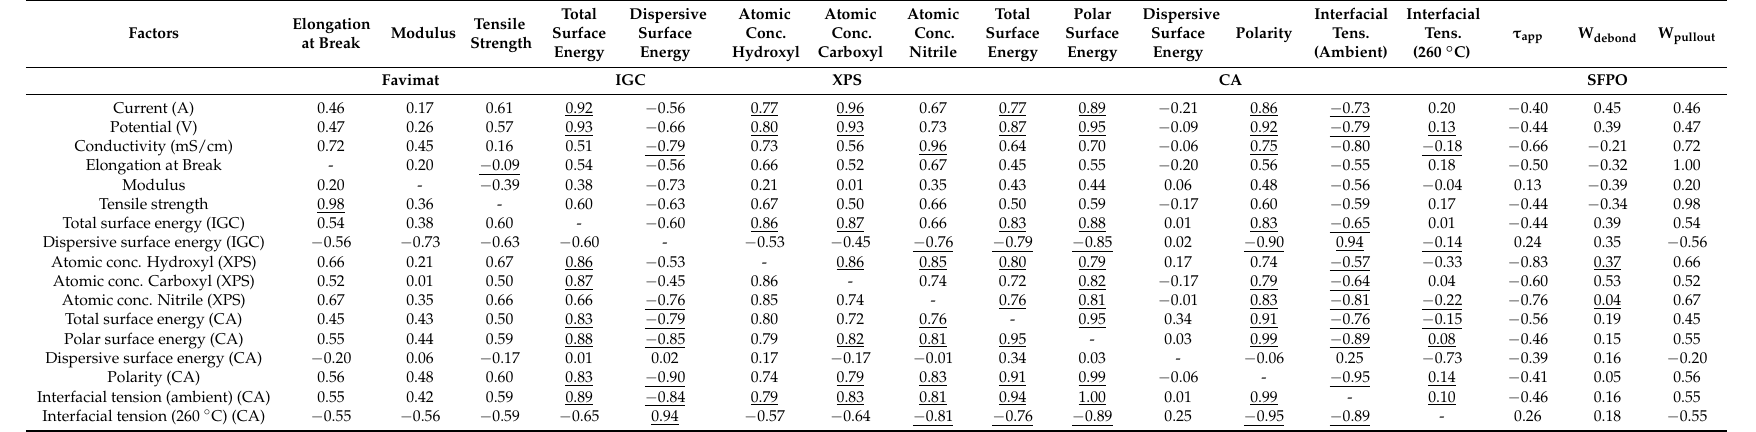
Table 8. Correlation factors on pair-wise comparisons between results, where 1 is the total positive linear correlation, 0 is no linear correlation, and − 1 is the total negative linear correlation. The underlined factors show p -values < 0.05 and are considered as significant.